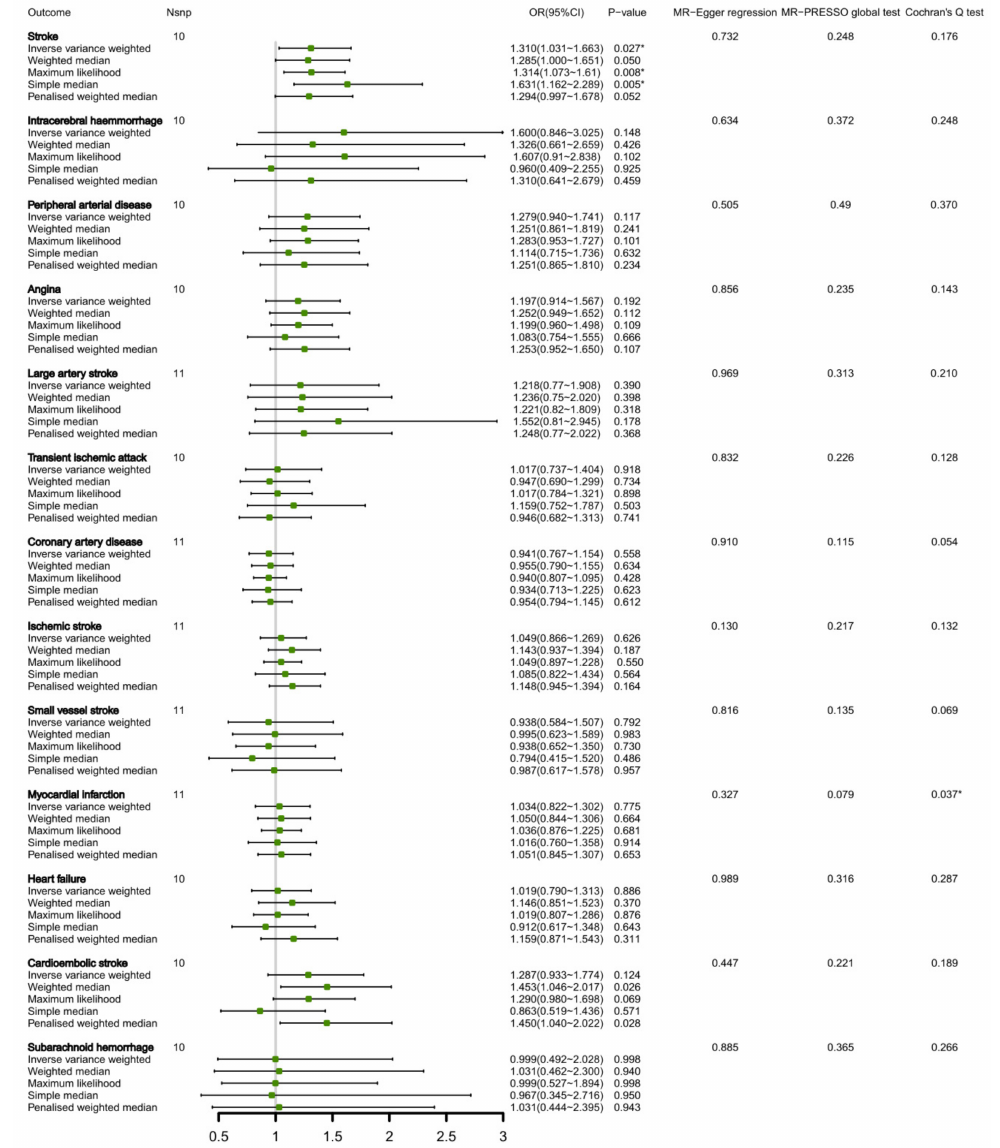
Figure 3. MR estimates of the relationship between CVDs and circulating leucine levels. * Indicates p < 0.05. Nsnp, number of